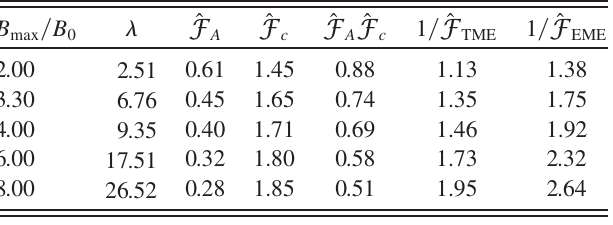
TABLE I. Potential performance of linearly increasing bending-radius profile in Eq. (A1) at several peak-field values. All quantities are normalized by equivalent uniform dipoles of equal length and bending angle, indicated by the caret on F .